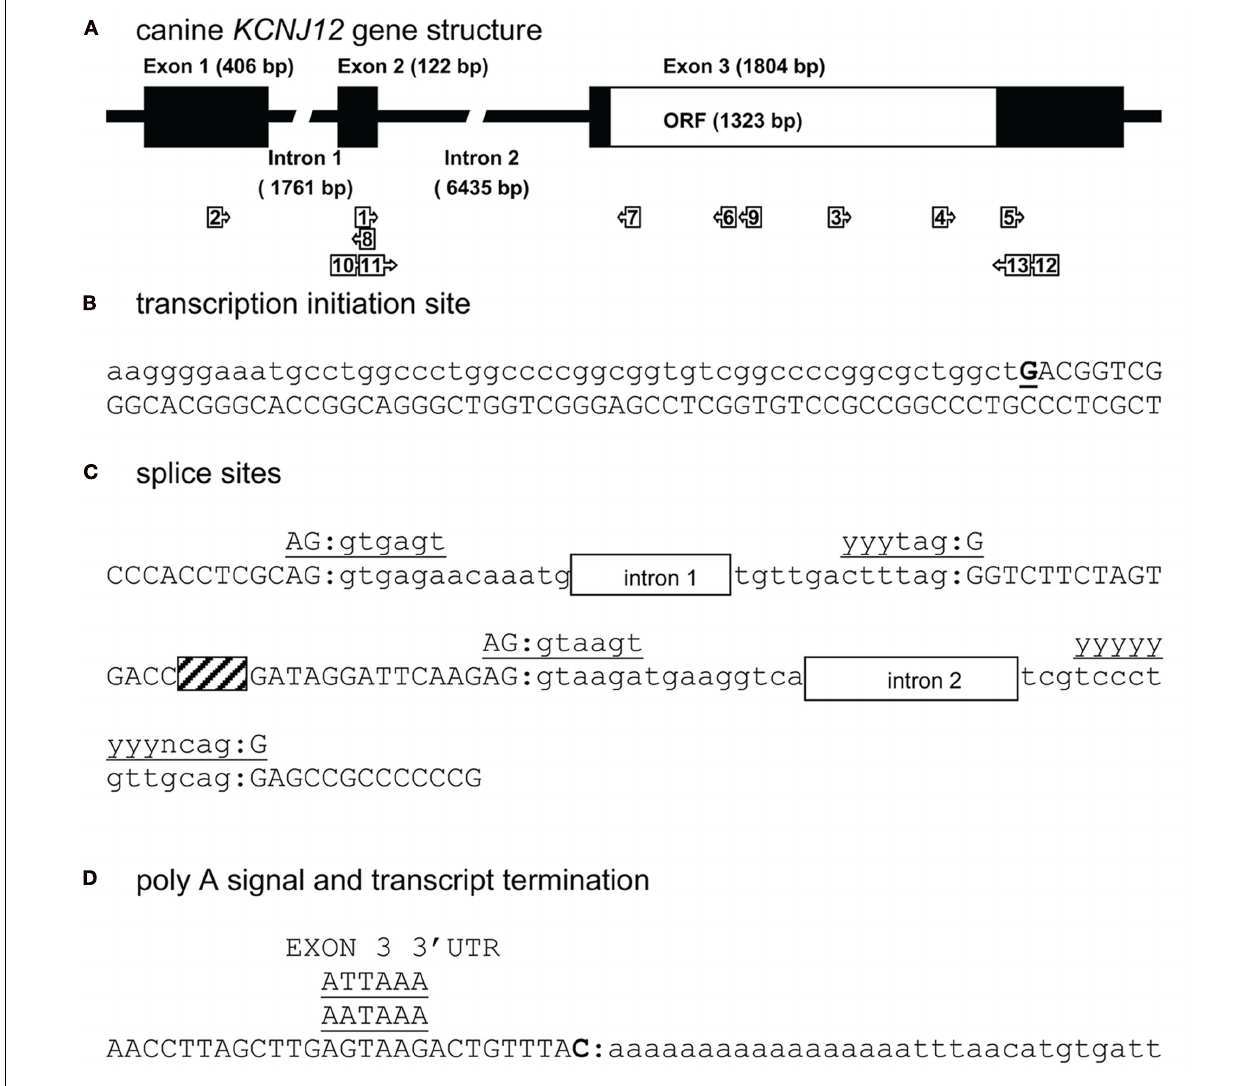
exon 1–intron 1, intron 1–exon 2, exon 2–intron 2, and intron 2–exon 3 splicing sites of dog KCNJ12 . Open bars indicate intron regions, hatched bar indicates exon 2 region. Exon sequences are indicated in upper case lettering, intron sequences in lower case. Consensus splicing sequences are indicated